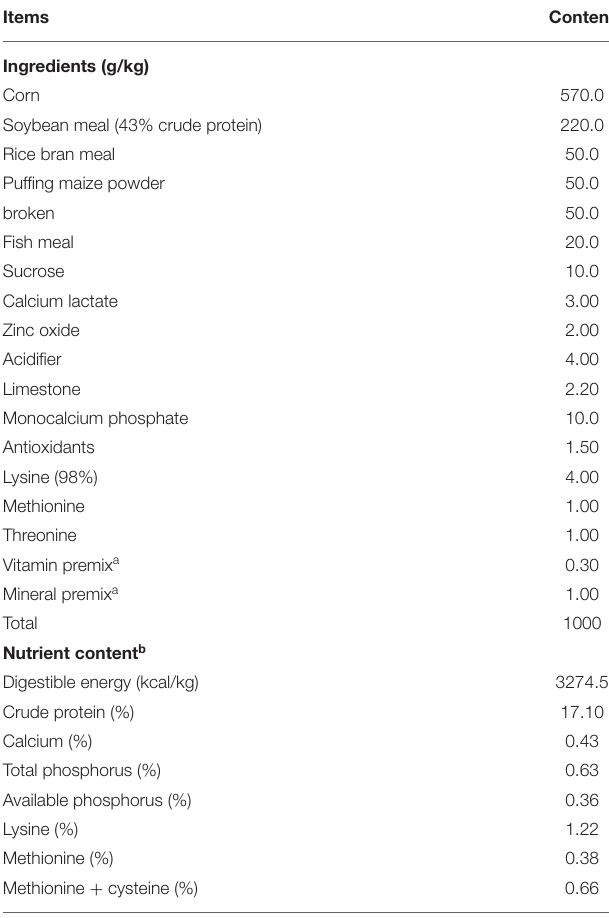
TABLE 1 | Composition and calculated nutrient levels of the basal diet (air-dry